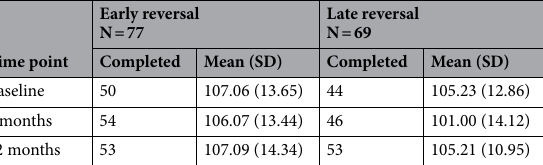
Table 4. Quality of life at baseline and at 6 and 12 months after low anterior resection. SD, standard deviation.